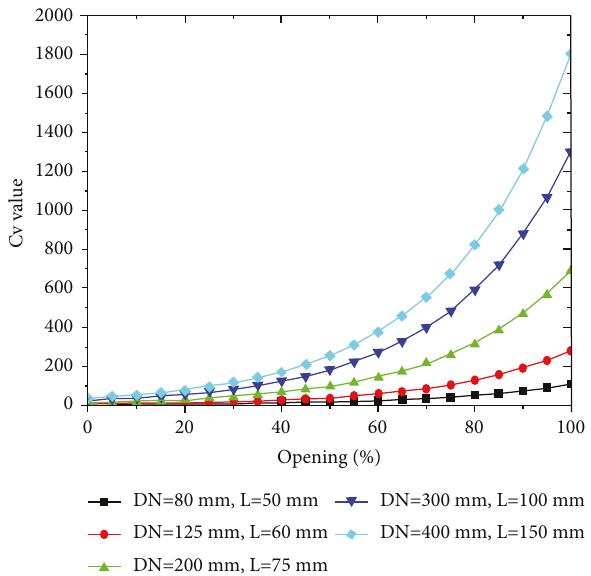
Figure 7: Variation of Cv for different strokes with different nominal diameters.